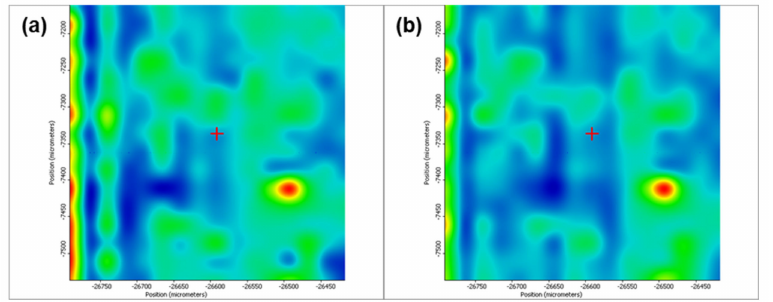
Figure 8. Second derivate IR mappings of Fe 3 O 4 @ β -CD thin films deposited at F = 500 mJ/cm 2 : surface intensity distribution of ( a ) 2930 cm − 1 and ( b ) 1029 cm − 1 .